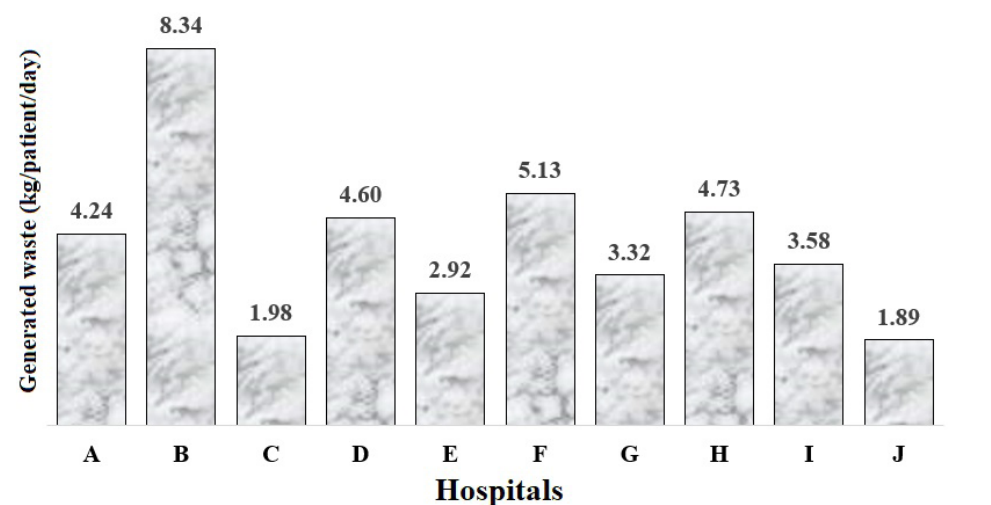
Figure 2. Medical waste generation in hospitals studied